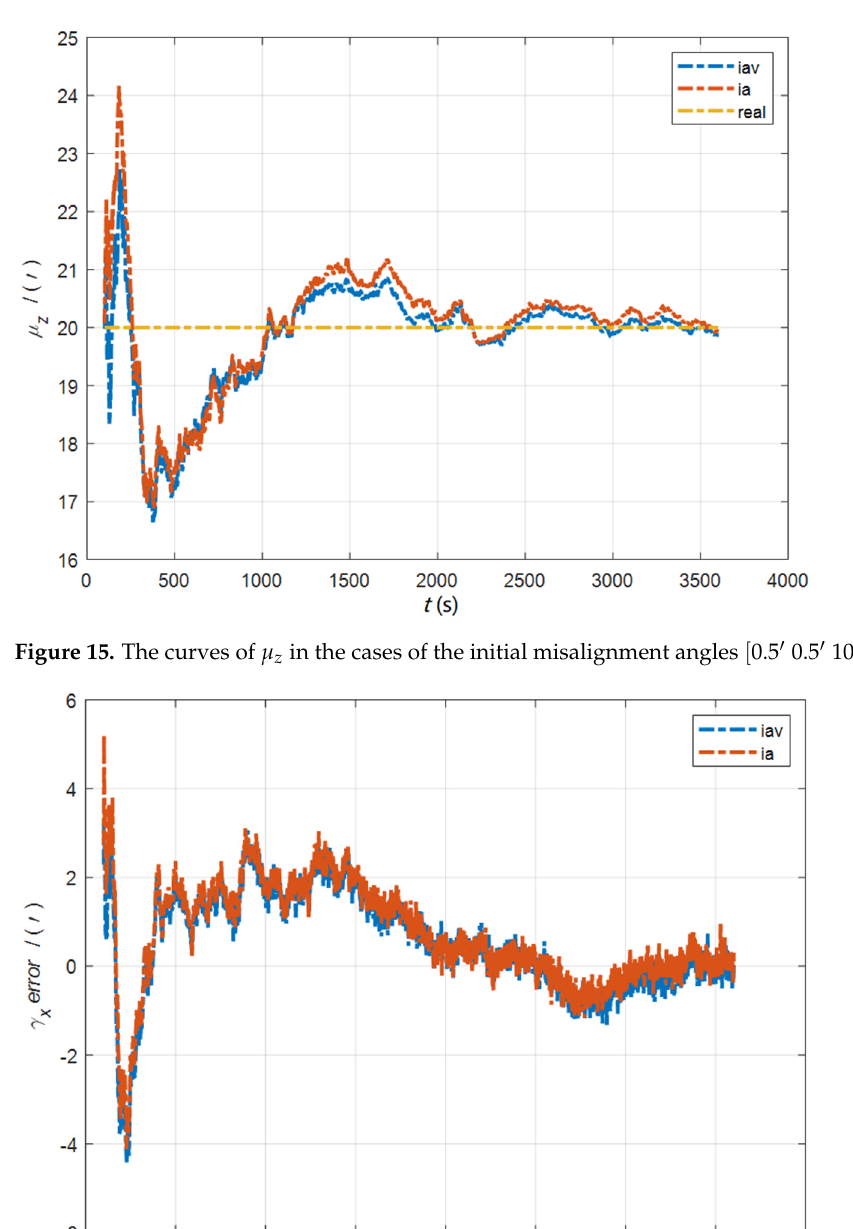
are similar, and the difference is no more than 3“.